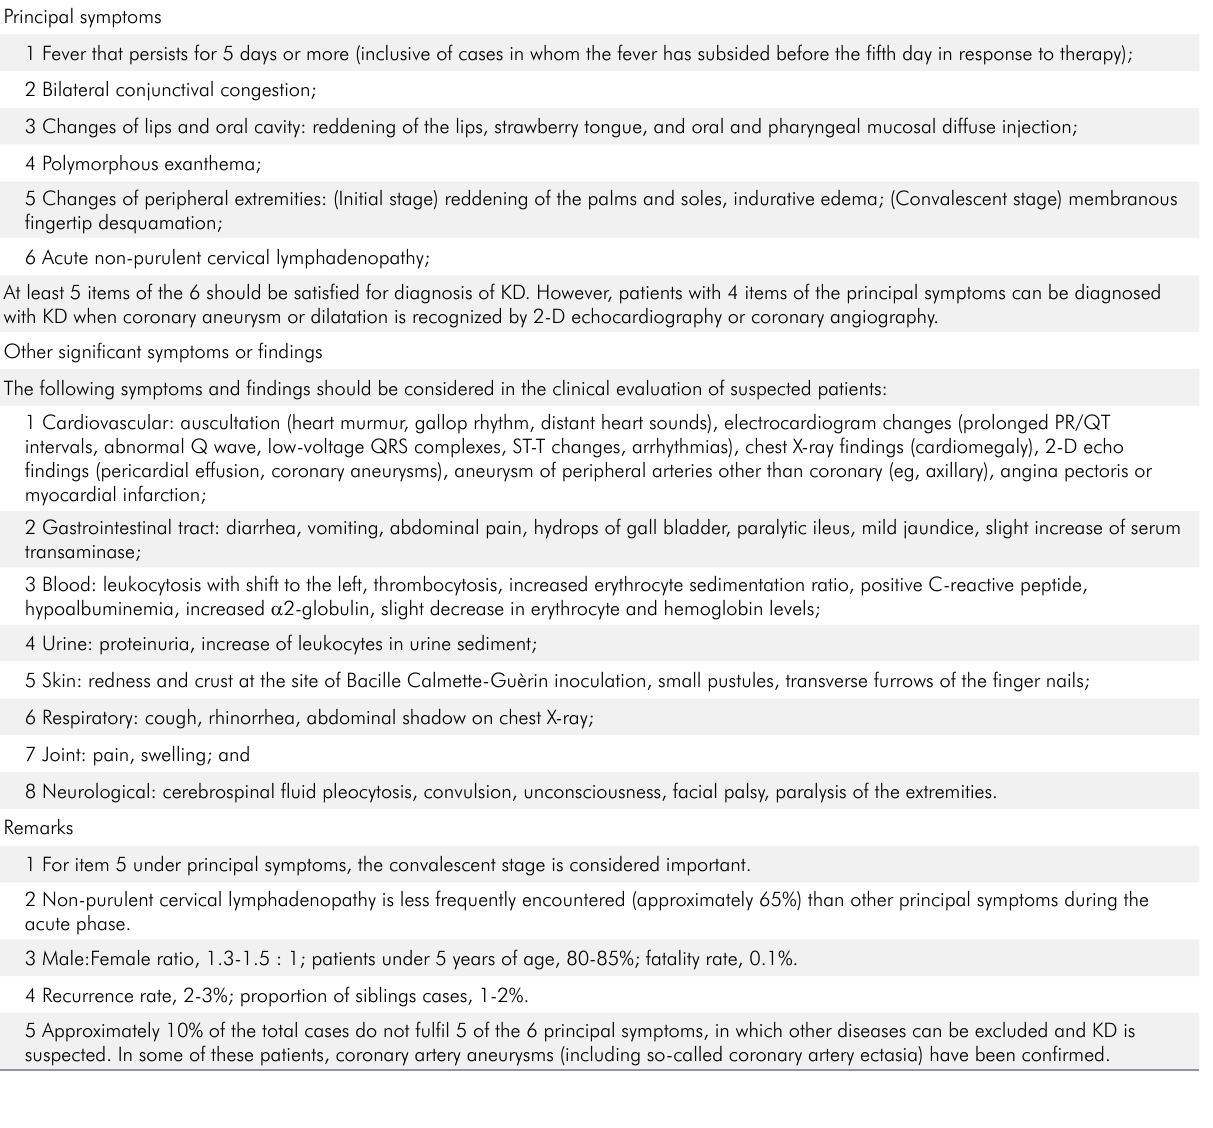
Table 1. Guidelines for the diagnosis of Kawasaki disease from Kawasaki Disease Research Committee (KDRC, 2002). 14 The symptoms can be classified into two categories, principal symptoms and other significant symptoms or findings: Principal